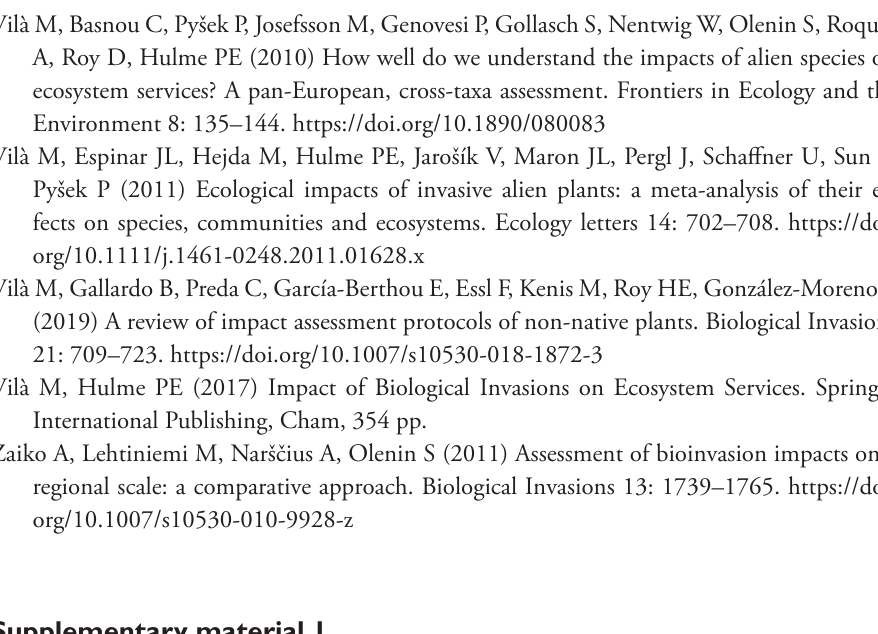
Explanation note: Figure S1: hierarchical cluster of the species scores for the six proto- cols common to all taxonomic groups. Figure S2: hierarchical cluster of the species scorings for plants and aquatic animals without correcting for sample size bias. Table S1: list of non-native species. Table S2: correlation